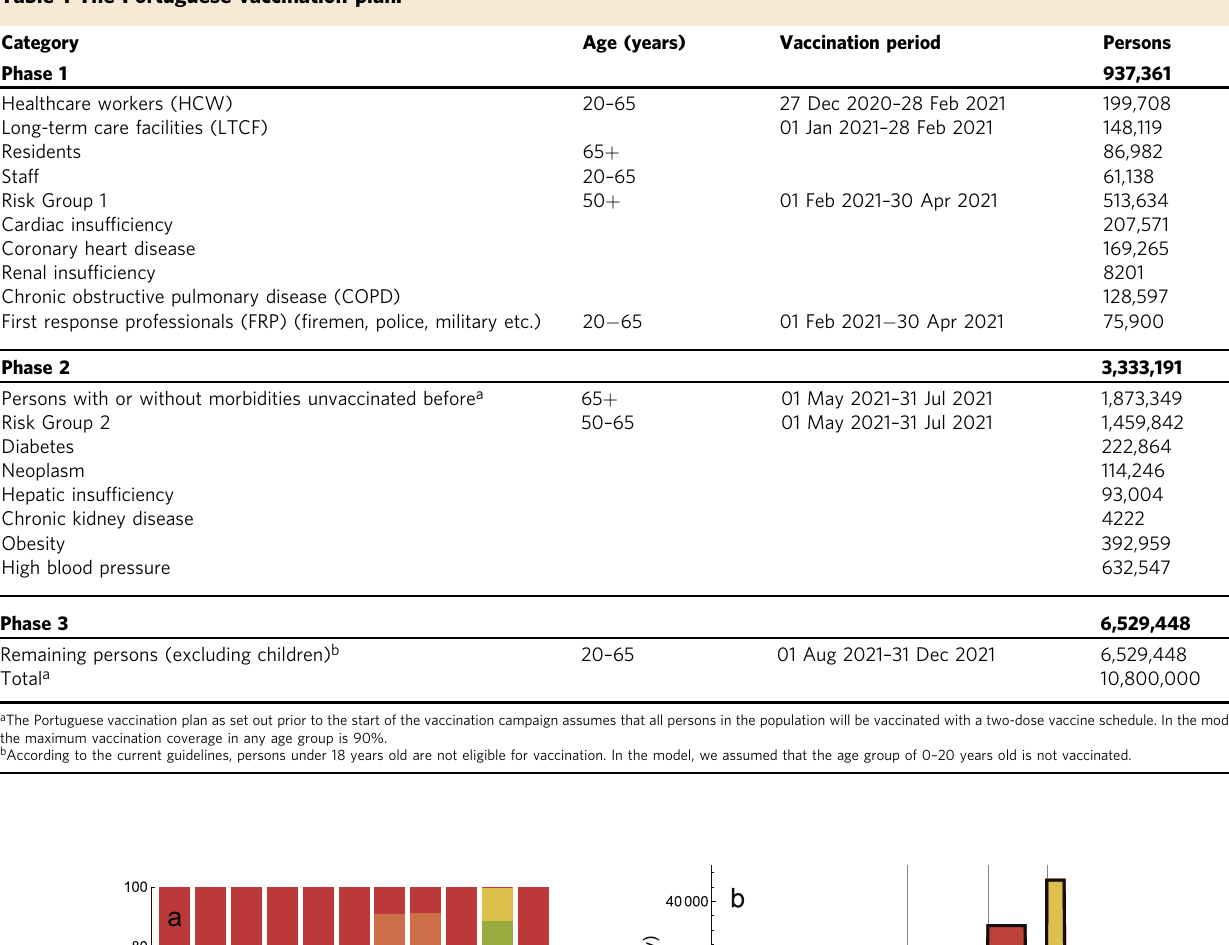
Table 1 The Portuguese vaccination